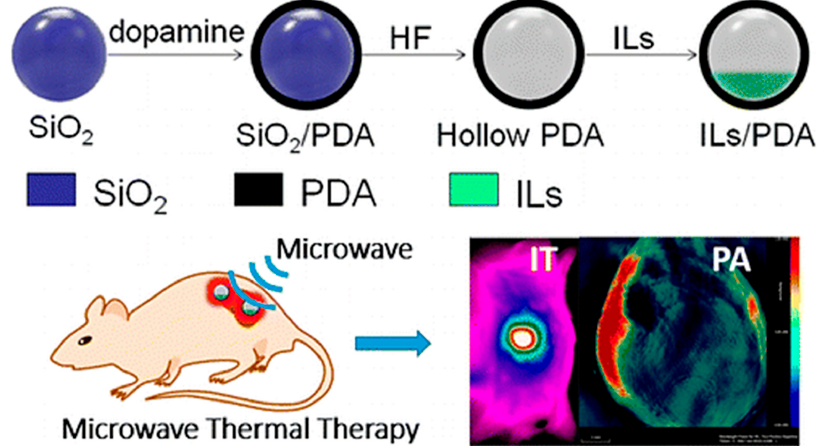
Figure 6. PDA capsules produced using a sacrificial SiO 2 template were filled with ionic liquids. In vivo, the capsules showed excellent e ffi ciency for microwave heating. Reprinted with permission from [109]. Copyright 2020 American Chemical